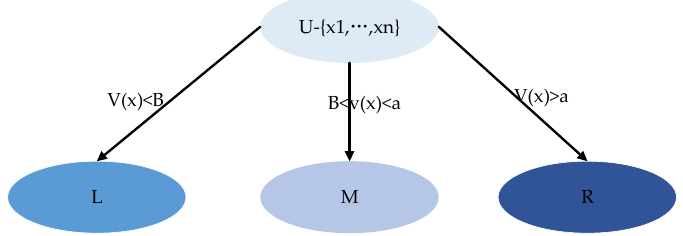
Figure 3. State diagram.